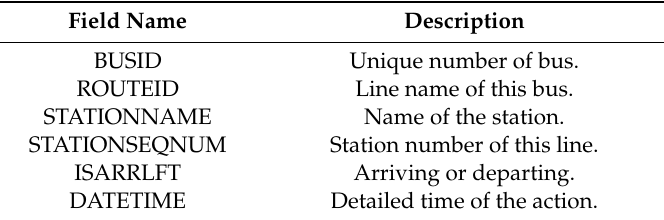
Table 2. Data structure of bus arrival and departure records.